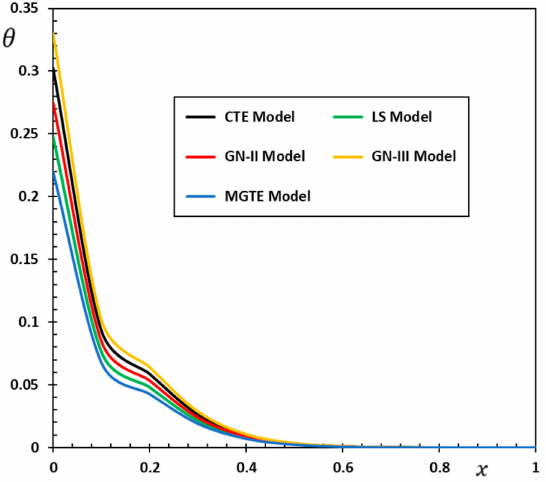
Figure 7. The thermal deflection w for various thermoelastic models.